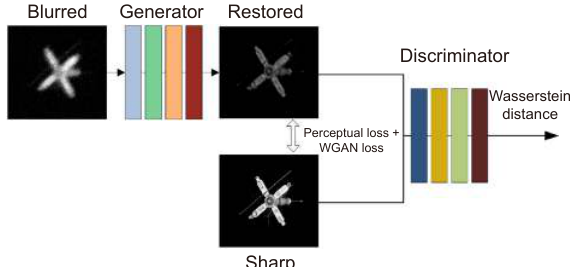
Fig. 18 | The flowchart of AO image restoration by cGAN. The whole network consists of two parts, generator network and discrim- inator network, which are used for learning the atmospheric degrada- tion process and achieving the purpose of generating restored im- ages. The loss function of the network is a combination of content loss for generator network and adversarial loss for discriminant net- work. Figure reproduced from ref. 96 , SPIE.